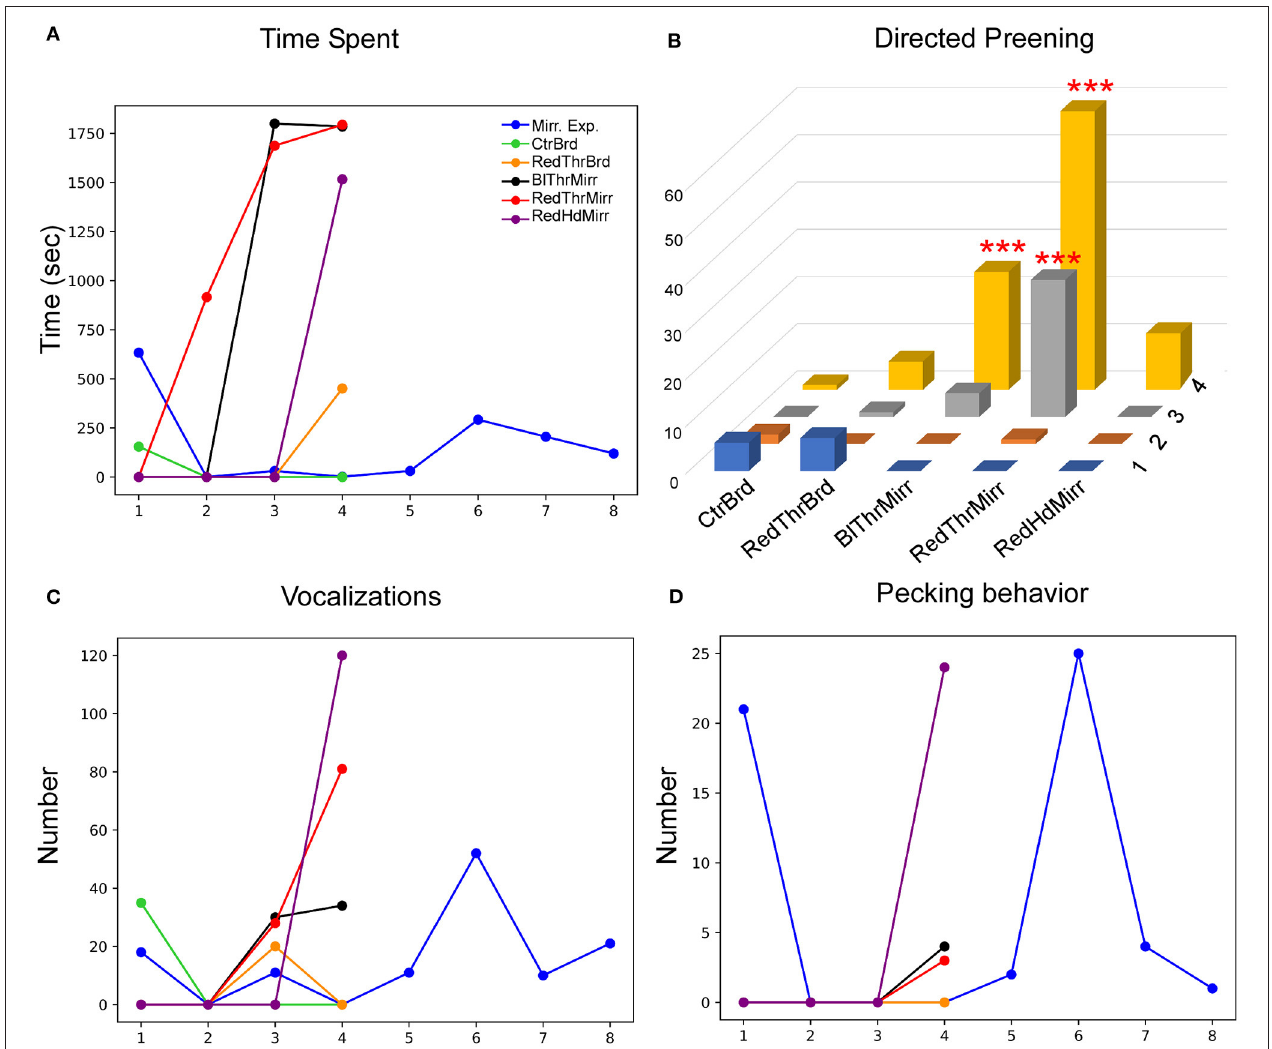
FIGURE 6 | Behavioral responses of another zebra finch (G123) while testing for MSR. (A) Whereas this bird spent less time facing the mirror during the mirror exposure trials, there was an increase in this parameter during Trial 3 and Trial 4 for the mirror conditions (RedThrMirr and BlThrMirr). (B) Mark-directed preening increased significantly for the RedThrMirr condition (Trials 3 and 4) and the BlThrMirr condition (Trial 4) vs. controls (***; P < 0.001; Fisher’s exact test). (C) Vocalization directed toward the mirror image was low in mirror exposure sessions and initial mirror trials but increased in the last mirror test trials. (D) There were no significant changes in pecking directed toward the mirror in any of the conditions